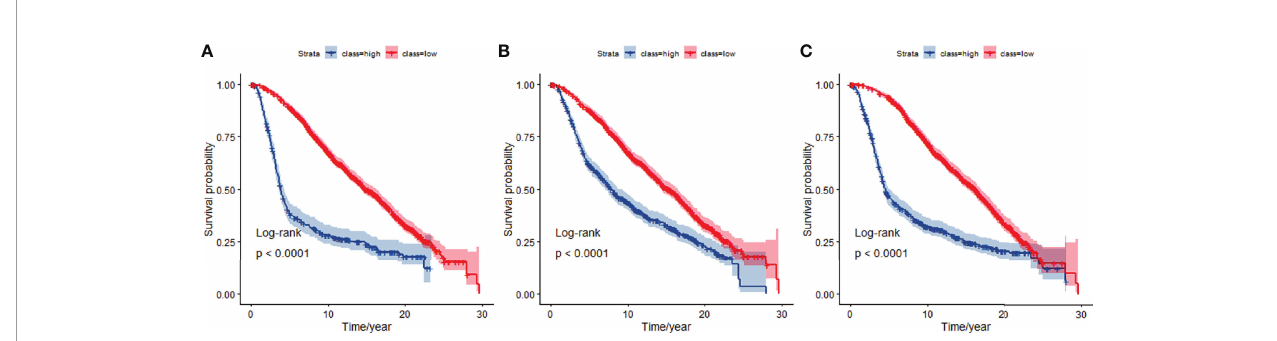
FIGURE 7 | Kaplan-Meier curves for overall survival at 5-year classi fi ers of mRNA expression data in METABRIC. (A) Kaplan-Meier curves for JDINAC classi fi er, (B) Kaplan-Meier curves for logistic regression classi fi er, and (C) Kaplan-Meier curves for random forest classi fi er.